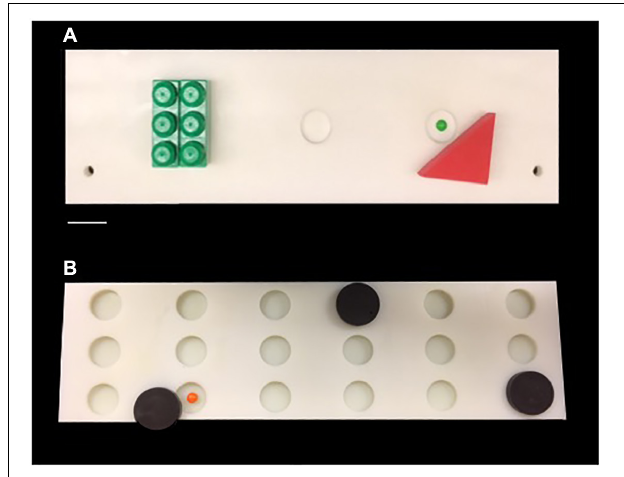
FIGURE 1 | (A) Photograph of the testing board used for Delayed Non-match Sample Task. (B) Photograph of the testing board used for Delayed Recognition Span Task. Scale Bar = 5.0